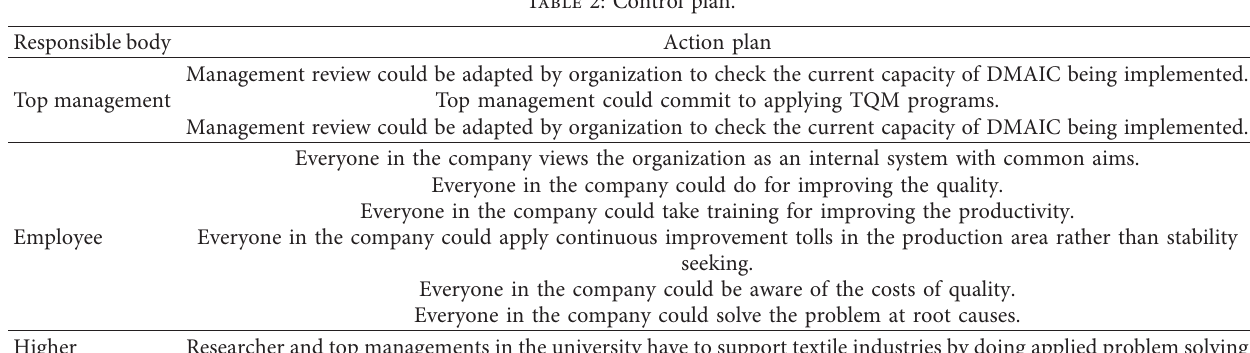
Table 2: Control